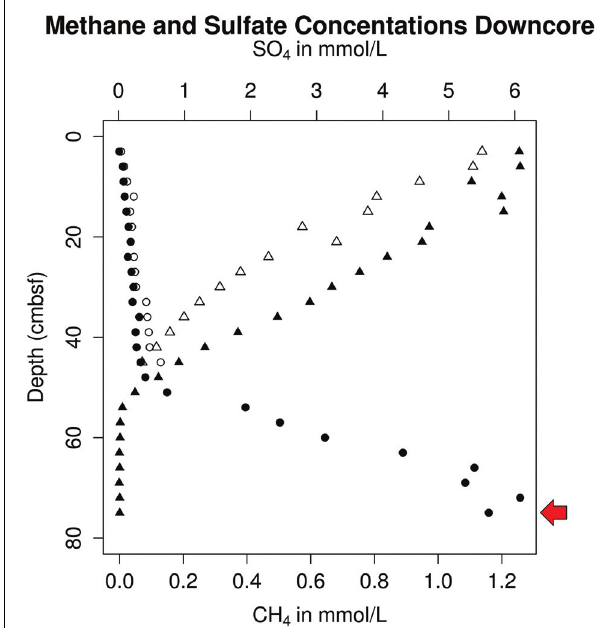
FIGURE 2 | Aqueous porewater concentrations of sulfate (triangles) and methane (circles) in replicate sediment cores (open/filled-in) taken from White Oak river estuary Station H in October 2012, with a red arrow indicating the depth at which samples for single-cell sorting were